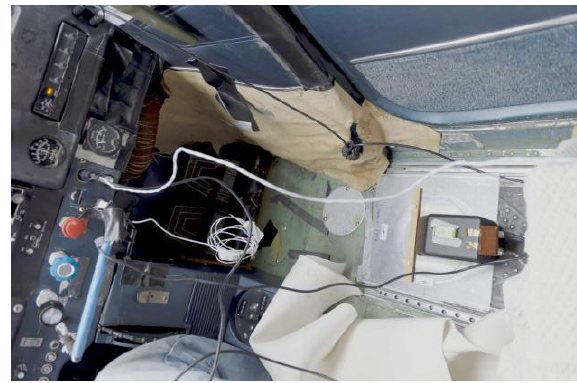
Figure 4. Installation of the FPI spectral camera in the floor opening in the manned aircraft. Table 2. Parameters of the MAV flight on